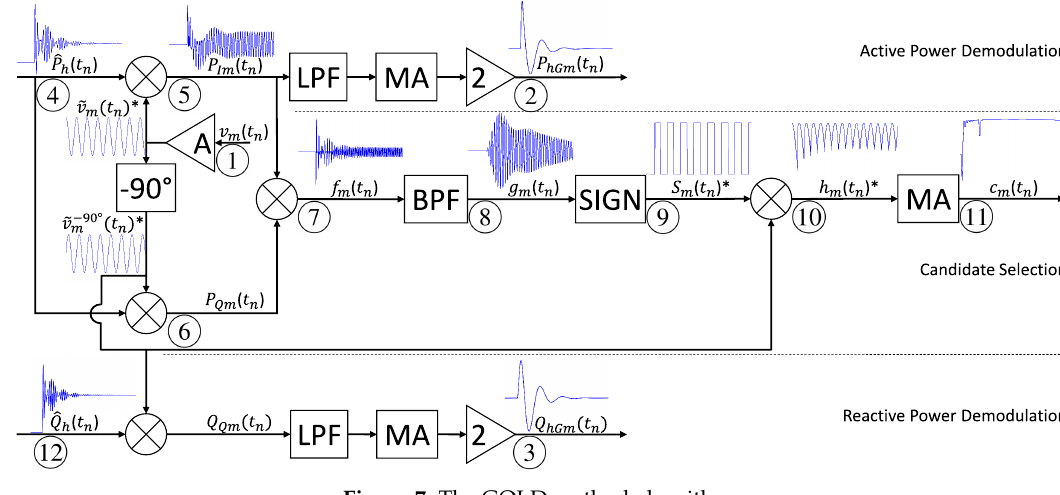
Figure 7. The GOLD method